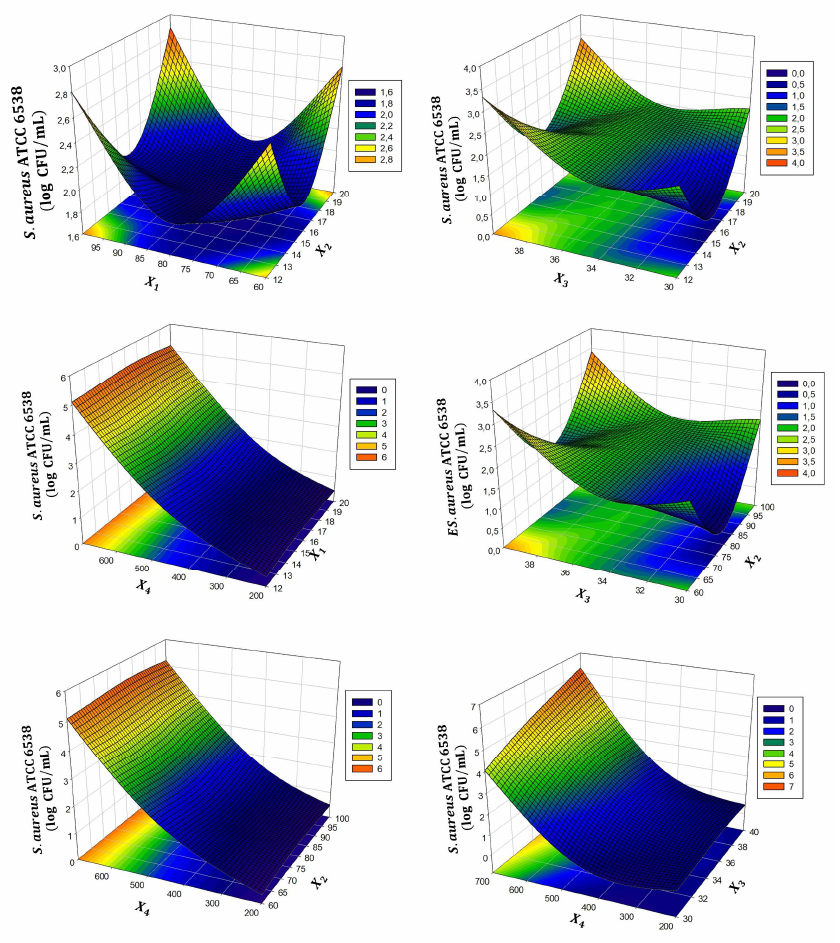
Figure 2. Three-dimensional response surface plots representing the effect of process variable on S. aureus ATCC 6538: (X 1 ) ultrasound time (min); (X 2 ) ultrasound amplitude (%); (X 3 ) microwave time (s); (X 4 ) microwave power (W).